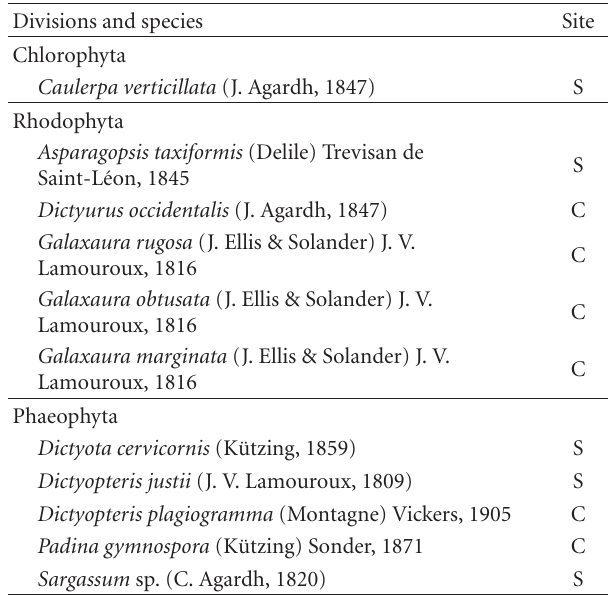
Table 1: Classification and sampling for eleven macroalgae studied in Fernando de Noronha archipelago, of northeastern